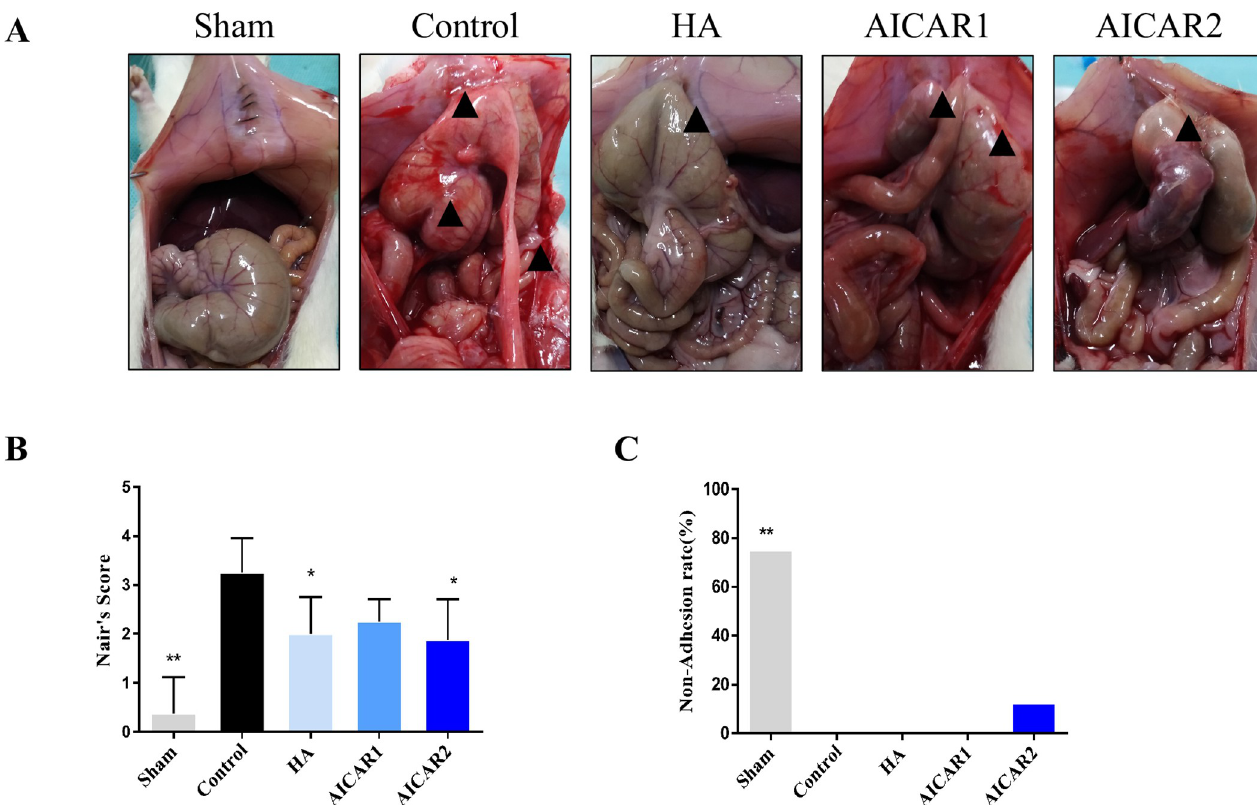
Fig 1. AICAR ameliorates adhesion scores and reduces inflammation in a rat model (n = 8). (A) A typical picture of the most representative adhesion situation of each group. The sham group included rats that received only open and close surgery. The control group had massive adhesion, while in the HA- and AICAR-treated groups, adhesion formation was relieved. The black arrow indicates the adhesion bands. (B) The Nair’s score of different groups, assessed by Kruskal–Wallis test. (C) The nonadhesion rate in each group. (compared to control, � represents p < 0.05, �� represents p < 0.01).